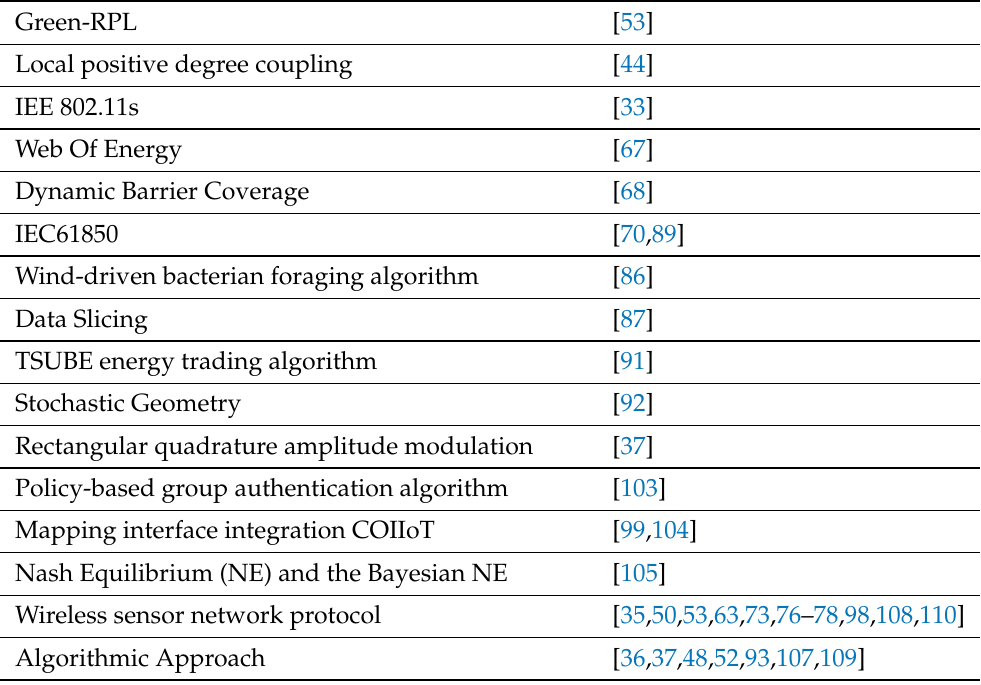
Table 9. Articles that can be classified by means of their Algorithms or